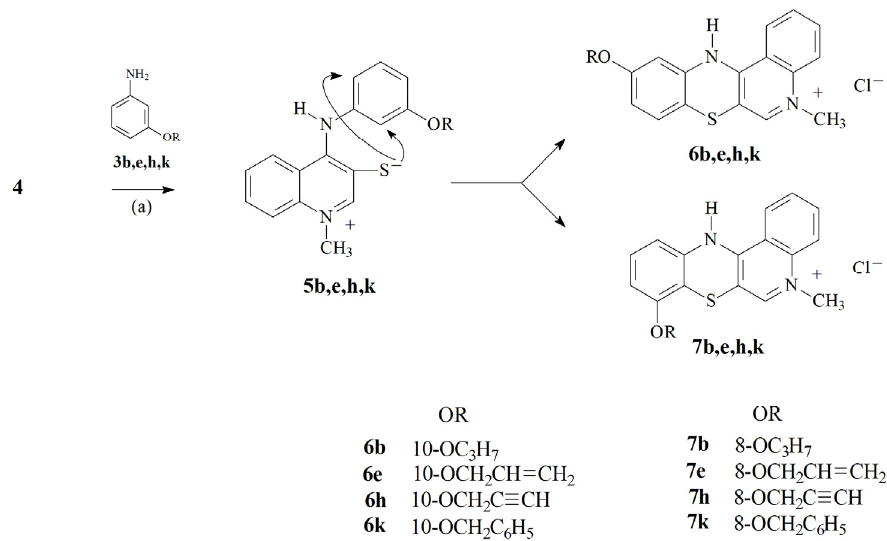
Scheme 3. Influence of the structure of intermediate products 5 on the direction of the cyclization reaction. ( a ) Procedure A: pyridine, 80 °C; Procedure B: pyridine, 20 °C.